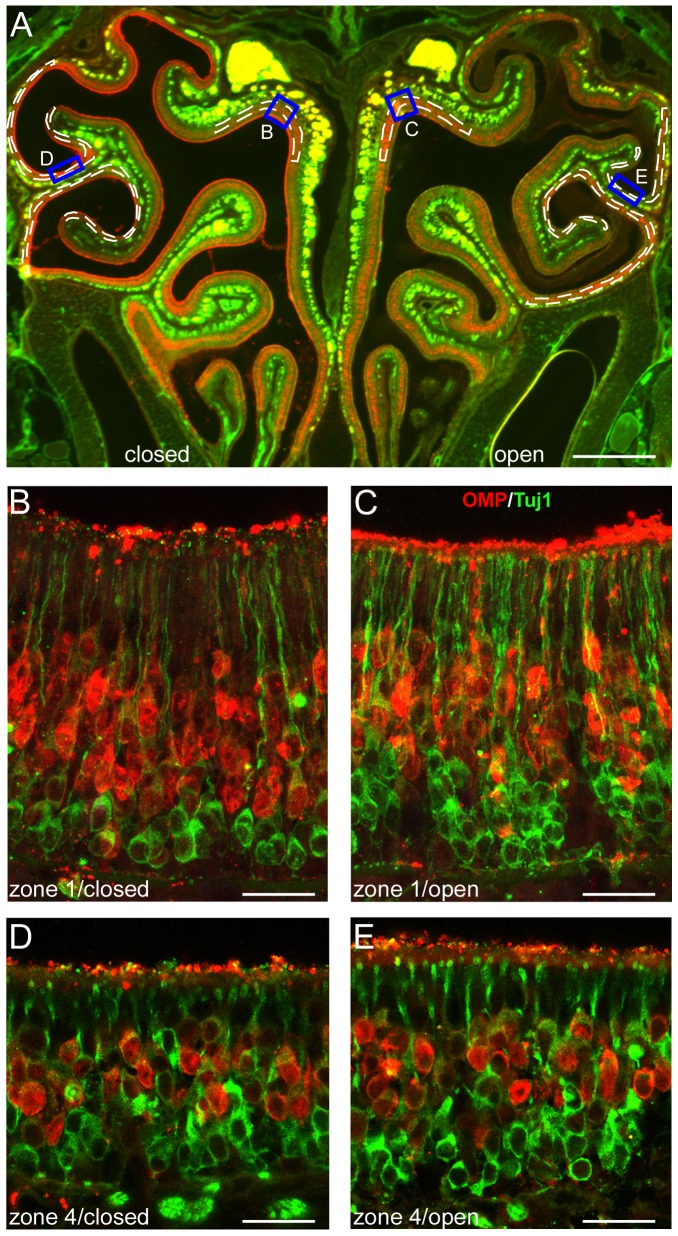
The thickness of mature OSN layer does not differ significantly between the closed and open side.Coronal sections from 4-week-old mice that underwent neonatal, unilateral naris closure were stained with antibodies against OMP (red) and a neuronal marker Tuj1 (green). (A) A low-magnification image shows an entire section. Scale bar = 0.5 mm. The rectangles indicate the approximate locations where confocal images in B to E were taken. The dashed lines illustrate how the thickness of the mature OSN layer is measured in defined regions of zone 1 and zone 4. (B–E) High-magnification confocal images (projected from a stack of 5 images with z step = 3 µm) were taken from zone 1 and zone 4 in the closed (B, D) and open side (C, E). Scale bars = 20 µm.